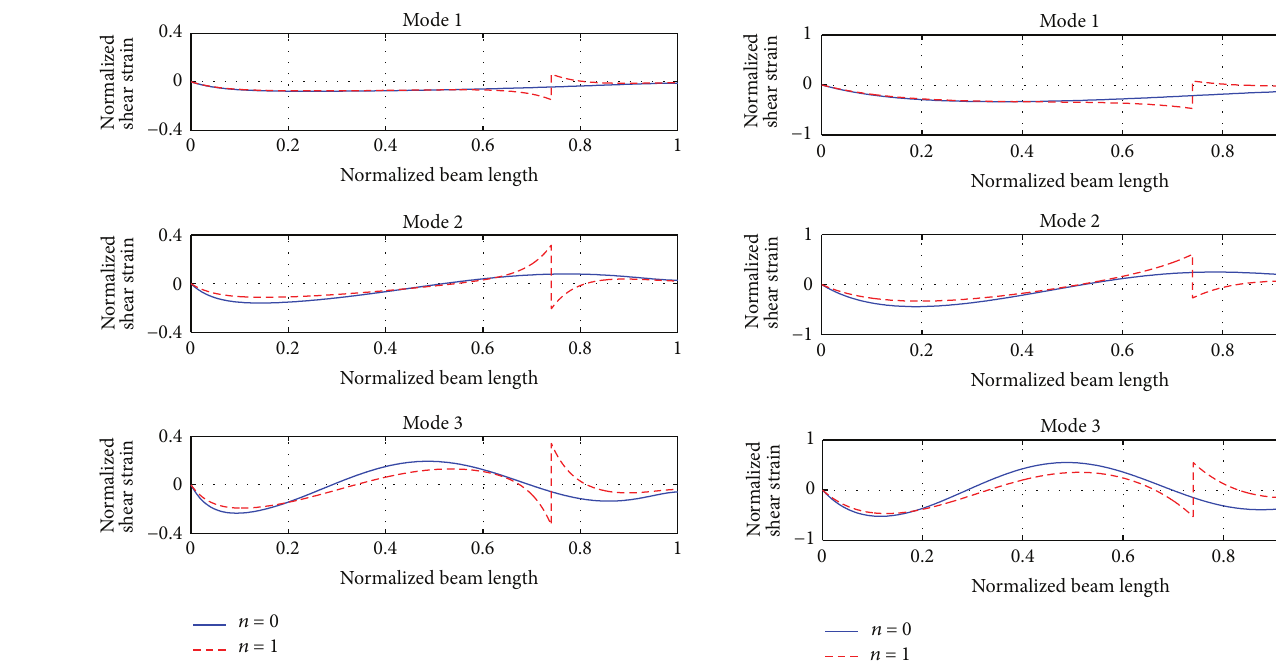
Figure 10: Comparison of the shear strain field between full-cover and segmented CLD beams with ratio 𝐻 𝑏 = 𝐻 𝑐 = 0.005